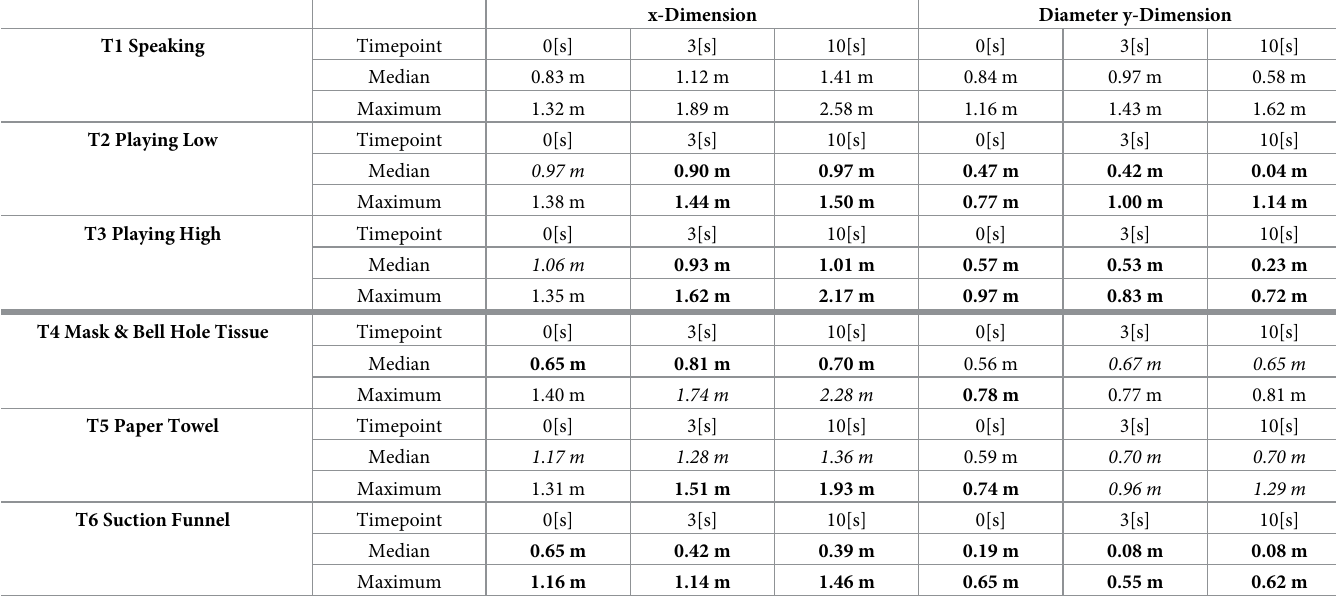
Table 1. The maximum and median values for all performed tasks.